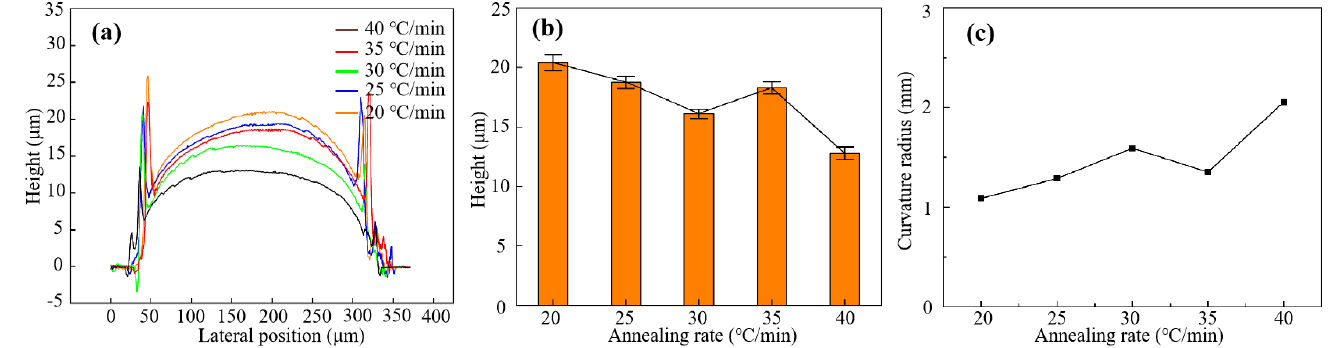
Figure 10. ( a ) Profiles, ( b ) maximum heights, and ( c ) curvature radii of microlenses under various annealing